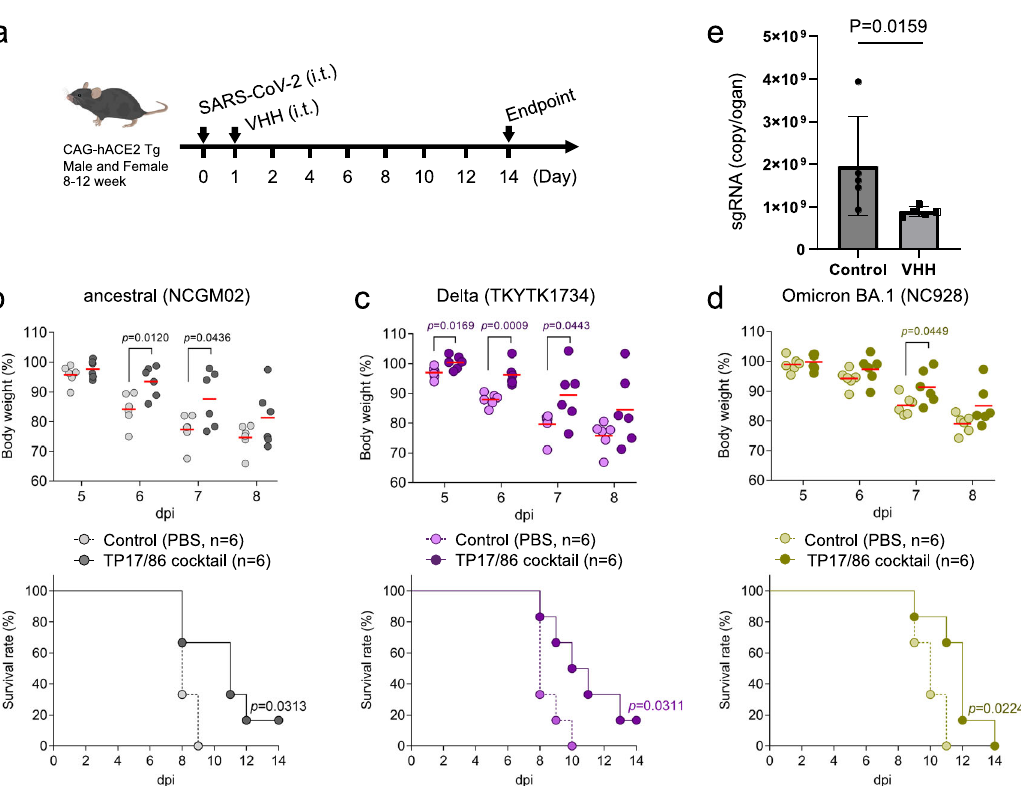
Fig. 2 The TP17/86 cocktail delays SARS-CoV-2 infection in huACE2 Tg mice. a Overview of the experiment design. Lethal dose of SARS-CoV-2 (ancestral strain and Delta, 1 × 10 4 TCID 50 ; Omicron, 1 × 10 5 TCID 50 ) was intratracheally (i.t.) inoculated to six mice (3 male and 3 females) and followed by the administration of the TP17/86 cocktail (dark colors) or vehicle (bright colors) at dpi 1. The TP17/86 cocktail suppressed body weight loss and prolonged survival of the mice infected with ancestral strain ( b ), Delta ( c ), and Omicron BA.1 ( d ). e Subgenomic RNA levels of SARS-CoV-2 Tokyo strain at dpi 3. Data are represented as the average and ± SD ( n =